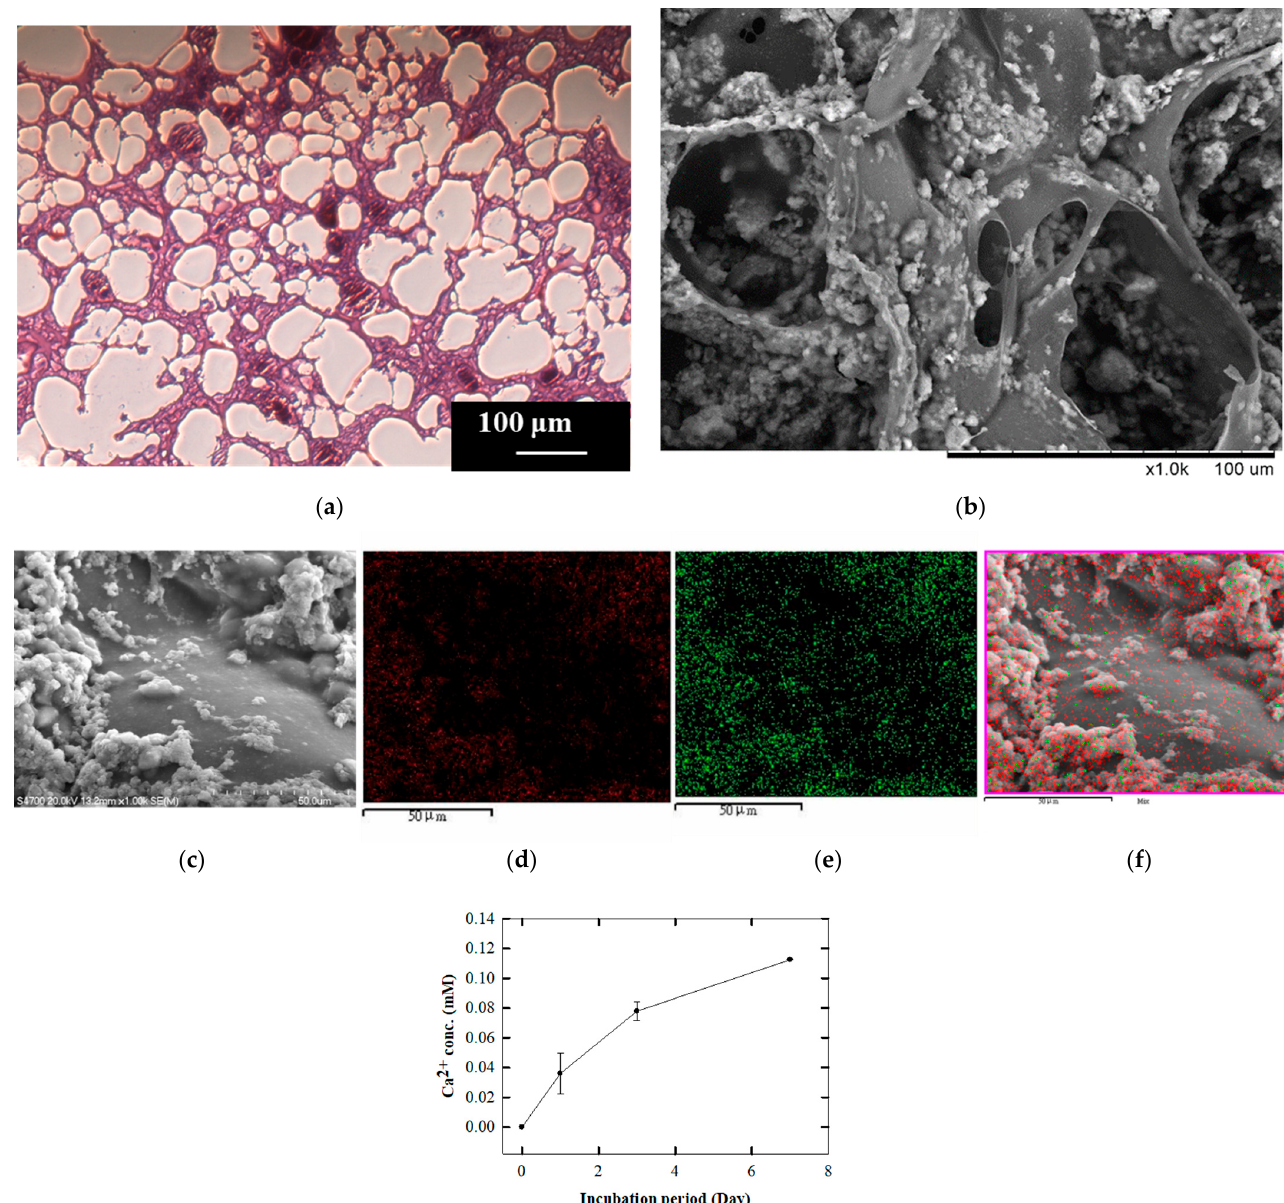
Figure 3. Analysis of the composition of the GHG scaffold: the protruding particle part in both the ( a ) HE stain and ( b ) SEM images indicate the HAp particles on the scaffold surface; the smooth part indicate the gelatin. ( c ) The SEM as changing the magnification showed the rough parts of the scaf- fold surface more clearly; EDX was used to analyze the distribution of ( d ) calcium ions and ( e ) phos- phorus ions, respectively; merged results of ( c – e ) pointed out that large amount of calcium ions was observed in the rough portion, as shown in ( f ). ( g ) Calcium ions released from the scaffold and free calcium ion concentration increased with time. (Scale bar: 100 µm for ( a , b ); 50 µm for ( c ) to ( f )). (The “×” in scale bar in the ( c ) represents magnification).